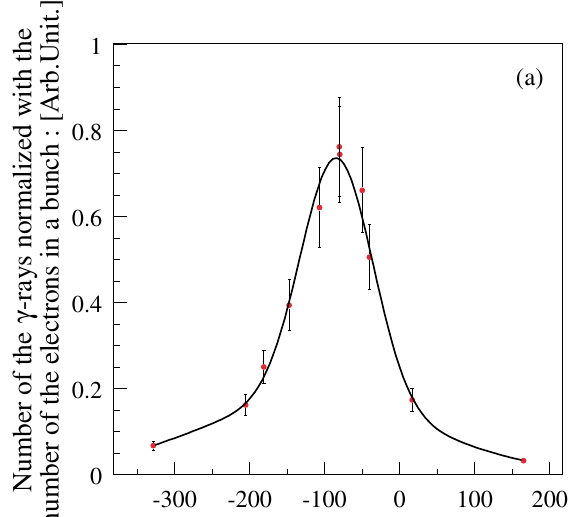
FIG. 17. (Color) Number of detected (cid:1) rays; the white histo- gram shows the laser-off signal and the red one shows the laser- on pared with the angle jitter, it may be assumed that (cid:29) equal to the angle jitter of the e (cid:1) beam ( (cid:29)